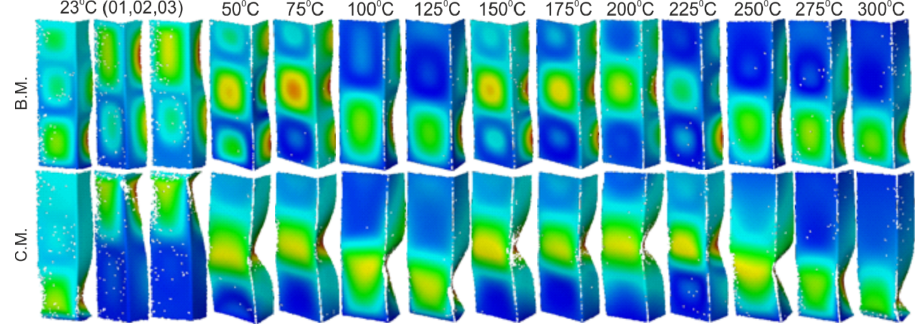
Figure 16. Buckling (B.M.) and collapse modes (C.M.) of considered profiles. Although in the experimental tests no changes in the buckling mode during the heating process and the compression after heating were found, in numerical calculations the above phenomenon took place. The phenomenon of changing the nominal buckling mode implemented in the numerical models in the form of initial imperfections concerned only the cases of changing two buckling half-waves into three. The key parameter was the amplitude of the initial deflections. It turns out that assuming the initial imperfections at the level of one hundredth of the wall thickness was insufficient for the heating process above 100 ◦ C (bilinear model) or 125 ◦ C (multiline model) not to change nominally implemented buckling mode. Nevertheless, the assumption of initial imperfections by an order higher (0.1 × t) led to the maintenance of the nominal buckling mode in the full range of the considered temperatures. It is mentioned that the declaration of the tangent modulus at the level of 0.001 and 0.01 did not generate changes in the buckling mode in any of different values of the tangent module. Table 9. Number of buckling half-waves along the column’s length